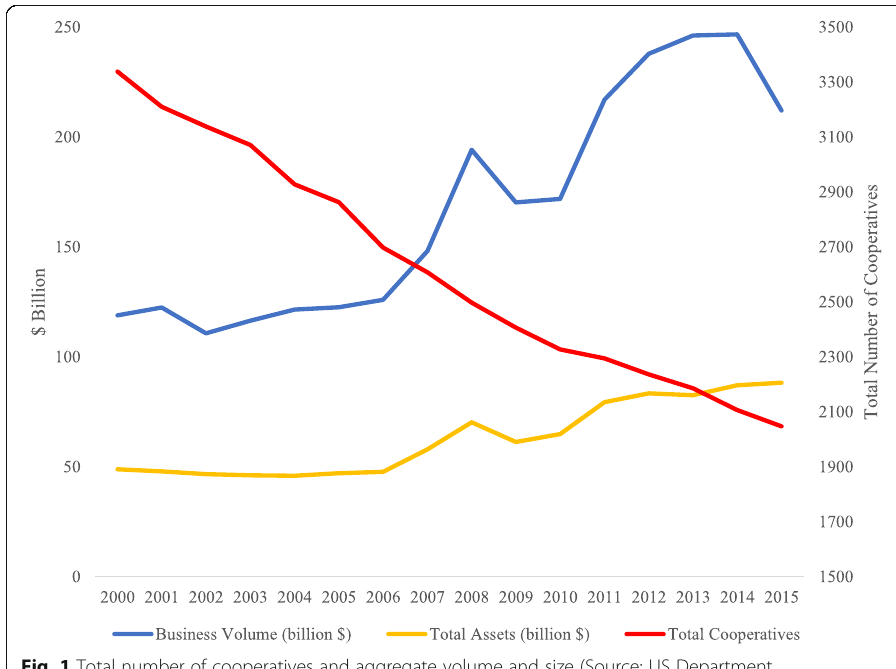
Fig. 1 Total number of cooperatives and aggregate volume and size (Source: US Department of